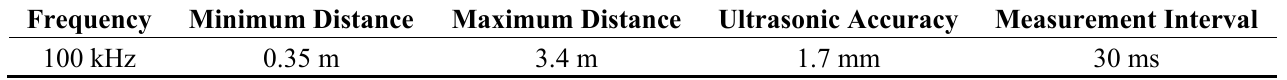
Figure 16. The layout of the central controller board and related interfaces. Table 1. Parameters of the ultrasonic